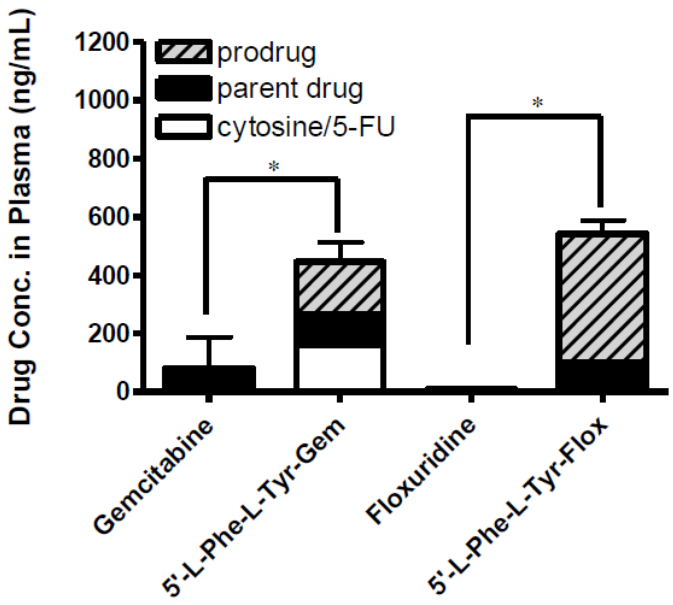
Figure 5. The concentration of floxuridine, floxuridine prodrug, gemcitabine and gemcitabine prodrug found in plasma at 2 h following in situ single-pass intestinal perfusion to the mouse jejunum. Each column represents prodrug, its parent drug, and its metabolite. Data are expressed as the concentration, ng/mL, mean ± SD, n = 3. Error bars are shown for the total concentration. * p < 0.05, the uptake amount of dipeptide prodrugs is compared with their parents, floxuridine and